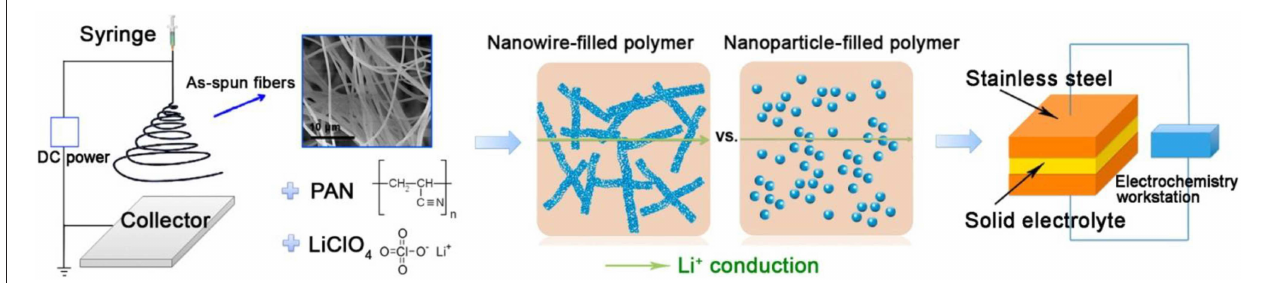
FIGURE 7 | Schematic illustration for the synthesis of ceramic nanowire-filled polymer-based composite electrolytes. [Reproduction with permission from Liu et al. (2015) Copyright © 2009, American Chemical